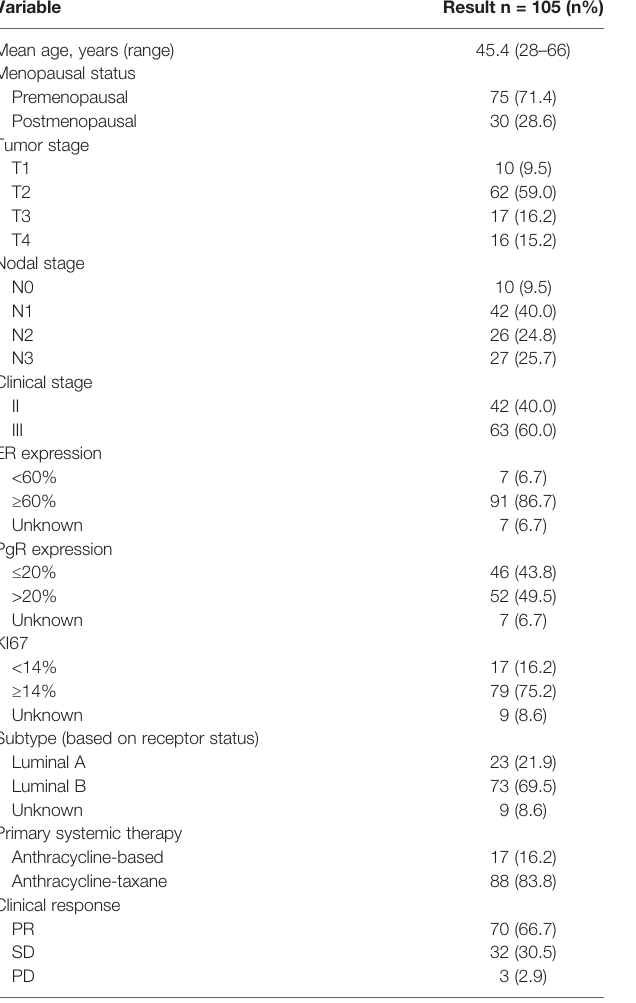
TABLE 1 | The preoperative clinicopathological characteristics of patients.